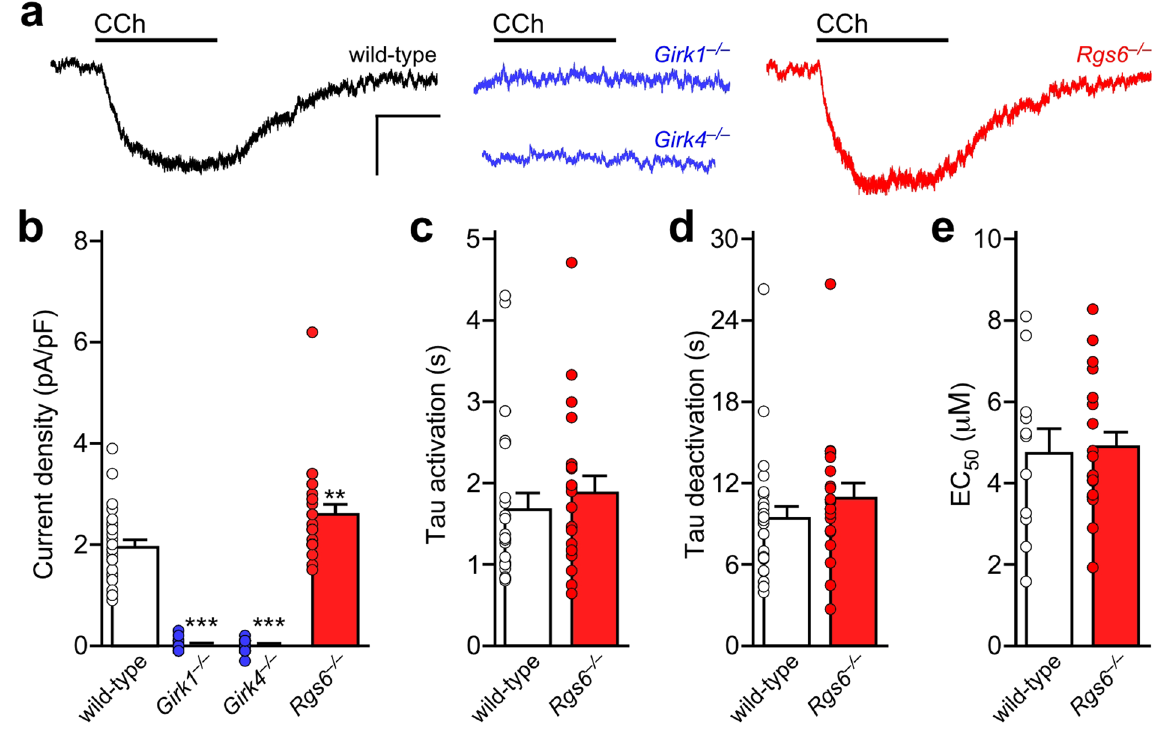
Figure 2. Carbachol-induced GIRK currents in adult mouse ventricular myocytes. ( a ) Whole-cell currents (V hold = − 70 mV) evoked by carbachol (CCh, 100 μ M) in a high-K + bath solution (containing 5 μ M BaCl 2 ) in adult ventricular myocytes from wild-type, Girk1 − / − , Girk4 − / − , and Rgs6 − / − mice. Scale: 0.1 nA/10 s. ( b ) Summary of maximal CCh-induced current density in adult ventricular myocytes from wild-type (n = 28 cells/6 mice), Girk1 − / − (n = 23 cells/4 mice), Girk4 − / − (n = 21 cells/4 mice), and Rgs6 − / − mice (n = 24 cells/6 mice); open symbols overlapping the bars denote individual data points. One-way ANOVA analysis revealed an effect of genotype on CCh-induced current density (F 3,92 = 110.6, P < 0.001). Symbols: ** , *** P < 0.01 and 0.001, respectively, vs. wild-type. ( c , d ) Summary of activation (c; t 44 = 0.7, P = 0.51) and deactivation ( d ); t 44 = 1.1, P = 0.28) kinetics for the CCh-induced current in ventricular myocytes from wild-type (n = 25 cells/6 mice) and Rgs6 − / − mice (n = 21 cells/6 mice), compared across genotypes using an unpaired Student’s